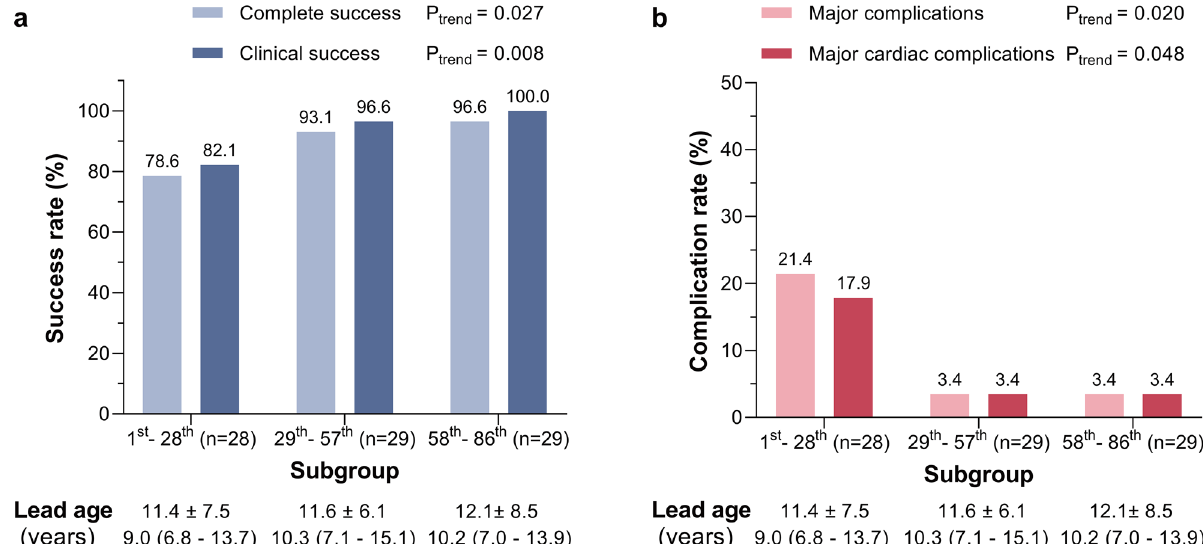
Figure 3. Change in outcomes according to experience with TightRail system . Patients were divided into three subgroups according to the accumulating experience with extraction procedure using TightRail system. A significant trend toward better efficacy ( a ) and safety ( b ) outcomes with more experience was observed although lead age was not significantly different among the three